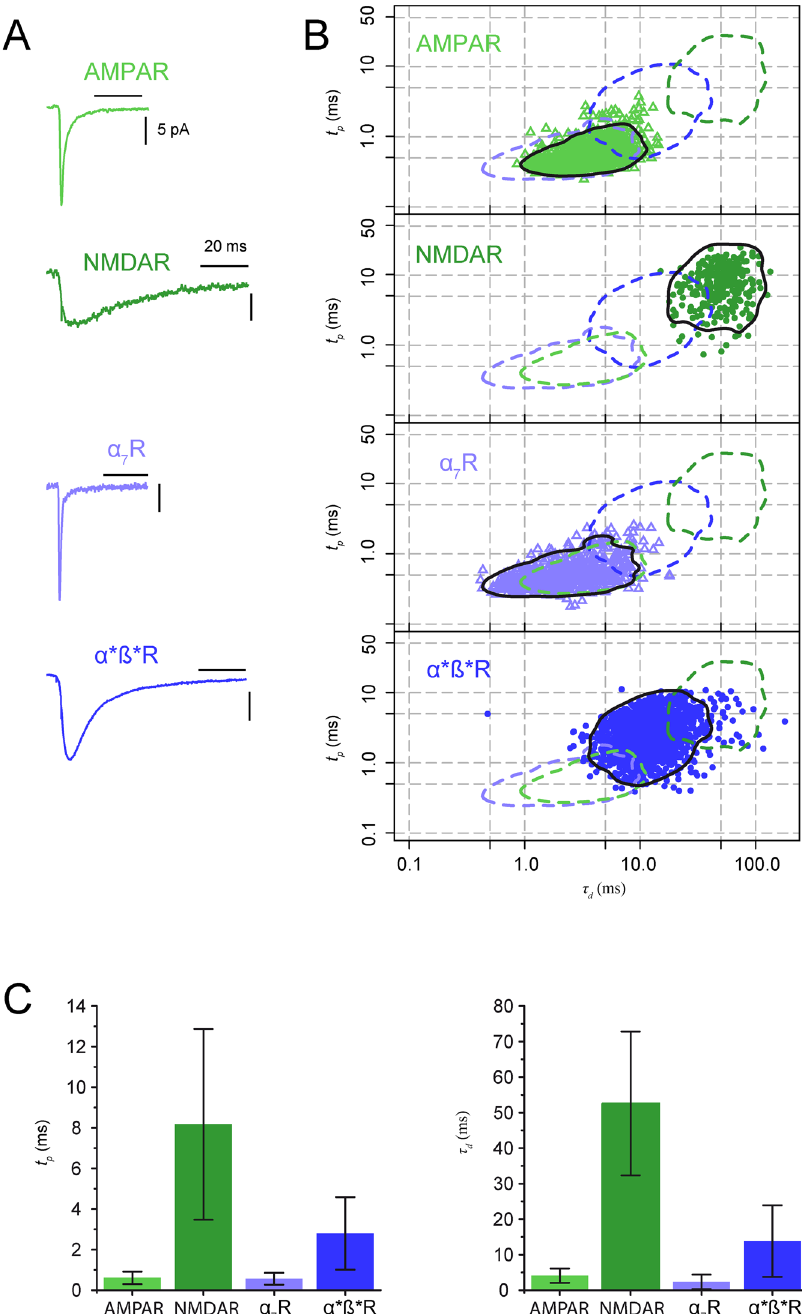
Figure 2. Rise time and decay of single-receptor type mEPSCS. The four types of single-receptor mEPSCs were recorded in the presence of TTX and antagonists: for AMPARs, D-APV, DHßE, MLA (N = 5 experiments, n = 1132 events); for NMDARs, NBQX, DHßE, MLA (N = 3, n = 286); for α 7 nAChRs, D-APV, NBQX, DHßE (N = 8, n = 923); for α * β * nAChRs, D-APV, NBQX, MLA (N = 6, n = 1714). The records and the distributions illustrated were taken at − 60 mV for a α 7 and α * β * nAChRs mEPSCs, and at − 40 mV for AMPAR and NMDAR mEPSCs. ( A ) Averaged records of single-receptor type mEPSCs. ( B ) t p vs τ d distributions for single-receptor type mEPSCs obtained from 5 (AMPAR), 3 (NMDAR) 8 ( α 7 nAChRs) and 6 ( α * β * nAChRs) experiments. The continuous black lines define the envelope of 95% of the events, the dotted lines are the envelopes of the three other distributions. ( C ) Mean values of t p and τ d for single-receptor type mEPSCs. The two parameters were measured in individual cells and the mean and the SD were obtained from the resulting values. The fastest mean rise times ( t p ) was that of α 7 nAChRs mEPSCs (0.51 ± 0.29 ms) and of the AMPARs mEPSCs (0.61 ± 0.31 ms). The α * β * nAChRs mEPSCs’ rise time was 2.80 ± 1.79 ms and the NMDARs mEPSCs had the slowest rise time (8.17 ± 4.69 ms). The mean decay time constants ( τ d ) of α 7 nAChRs mEPSCs (2.38 ± 2.03 ms) and of the AMPARs mEPSCs (4.11 ± 2.02 ms) were smaller than those of α * β * nAChRs mEPSCs (13.83 ± 10.07 ms) and of NMDARs EPSCs (52.57 ± 20.23